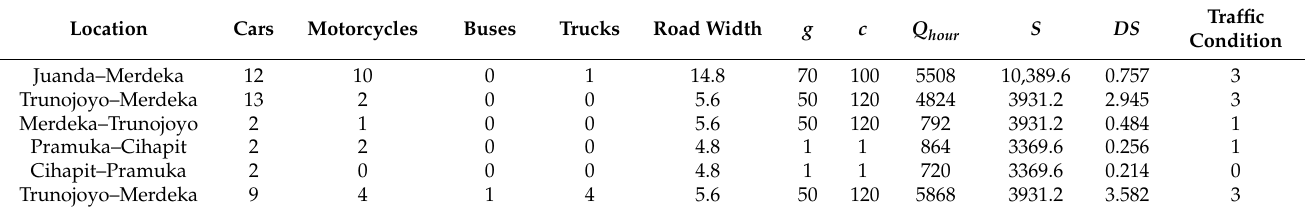
Table 16. Traffic condition measurement results based on CCTV.